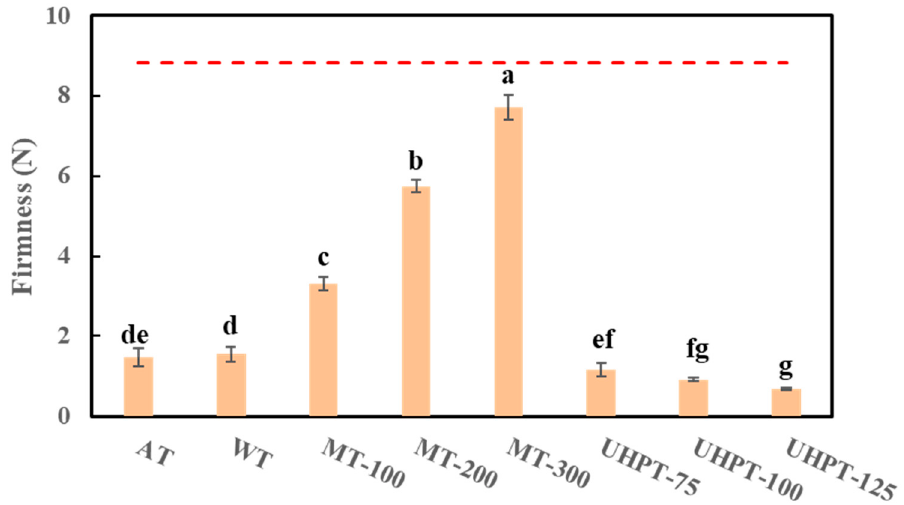
Figure 3. The firmness of thawed mangoes that were affected by different thawing conditions. The dotted line represents the firmness of the fresh mango. The different lowercase letters mean the significant difference among thawing conditions ( p < 0.05).